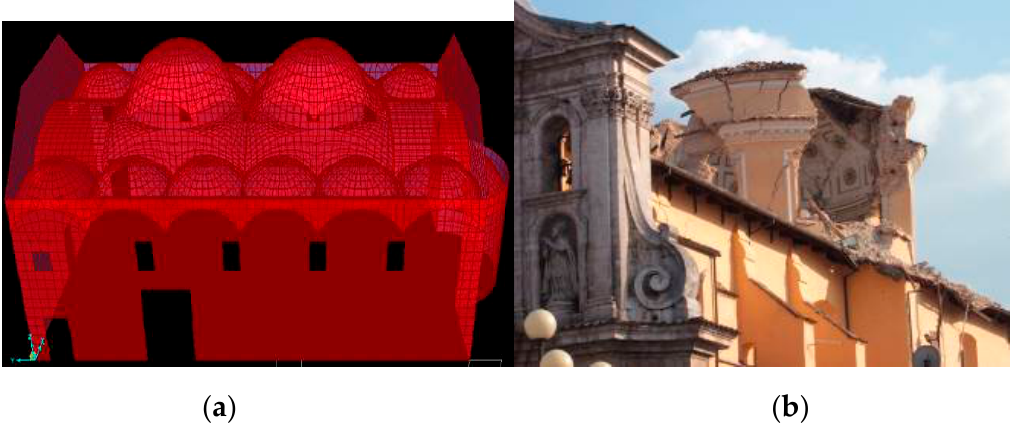
Figure 2. ( a ). Masonry vaulting; ( b ). Church of delle Anime Sante, L'Aquila earthquake 2009.